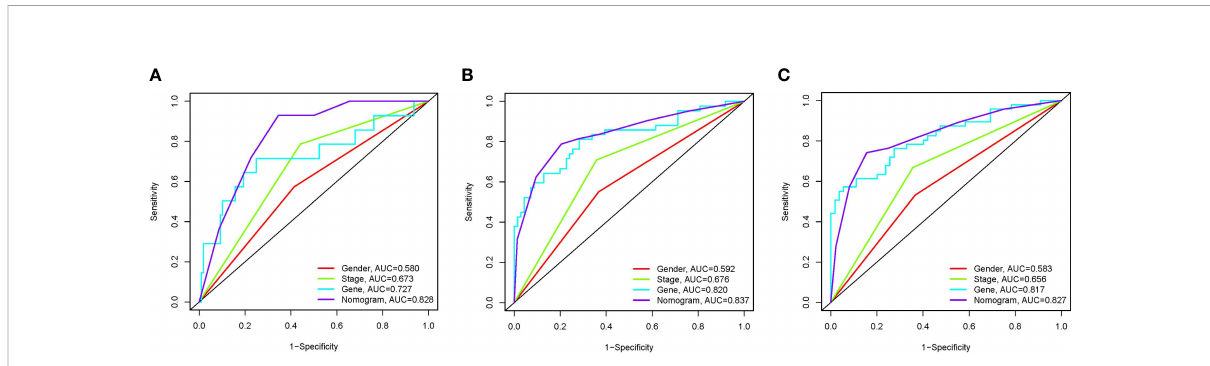
FIGURE 8 The AUC was used to estimate the predictive power of different models. ( A ROC for 1 year; B ROC for 3 years; C ROC for 5 years). The predictive ability of the nomogram (purple,1-,3-,5- year AUC= 0.828,0.837,0.827) was better than those of the other risk models.